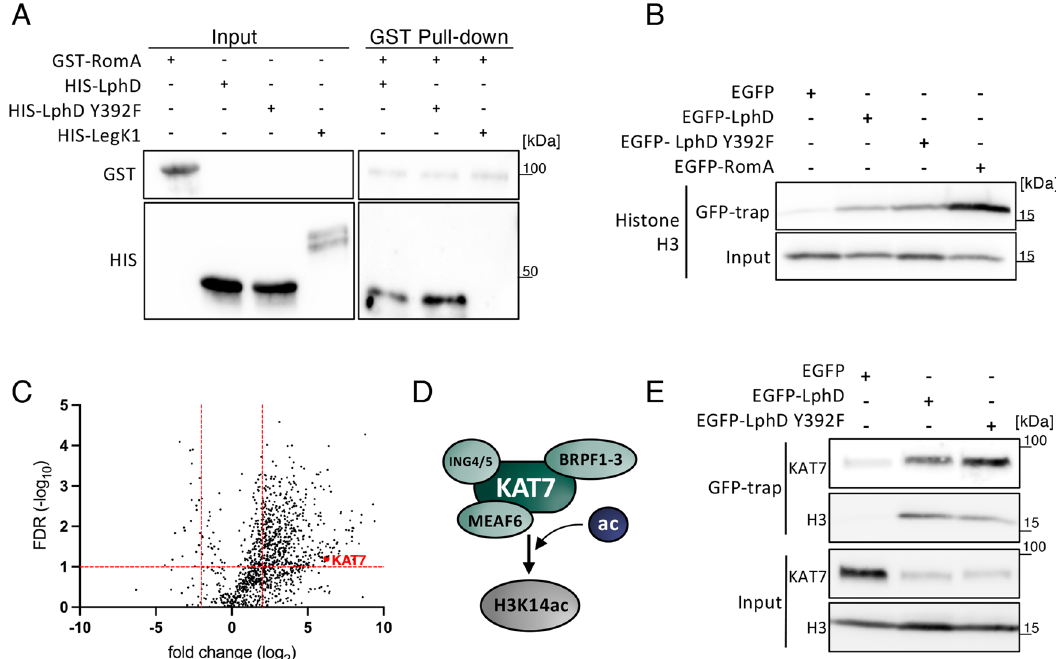
Fig. 5 | LphD and RomA interact and target chromatin. A In vitro protein interaction assay using puri fi ed GST-RomA and His-LphD. Puri fi ed proteins were mixed in equal amounts followed by a GST-pulldown using Glutathione-beads. HIS 6 -LegK1 was used as negative binding control. Representative of n =3 inde- pendentexperiments.Sourcedataprovidedassource fi le. B Immunoblotsshowing the interaction of LphD and RomA with histone H3. GFP-trap in HEK293T cells transfected with EGFP, EGFP-LphD, EGFP-LphD-Y392F, or EGFP-RomA. Pulldown samples were analyzed for the presence of H3. Input shows the expression level of endogenous histone H3 total lysate (IP control FigureS5B).Representative of n =3